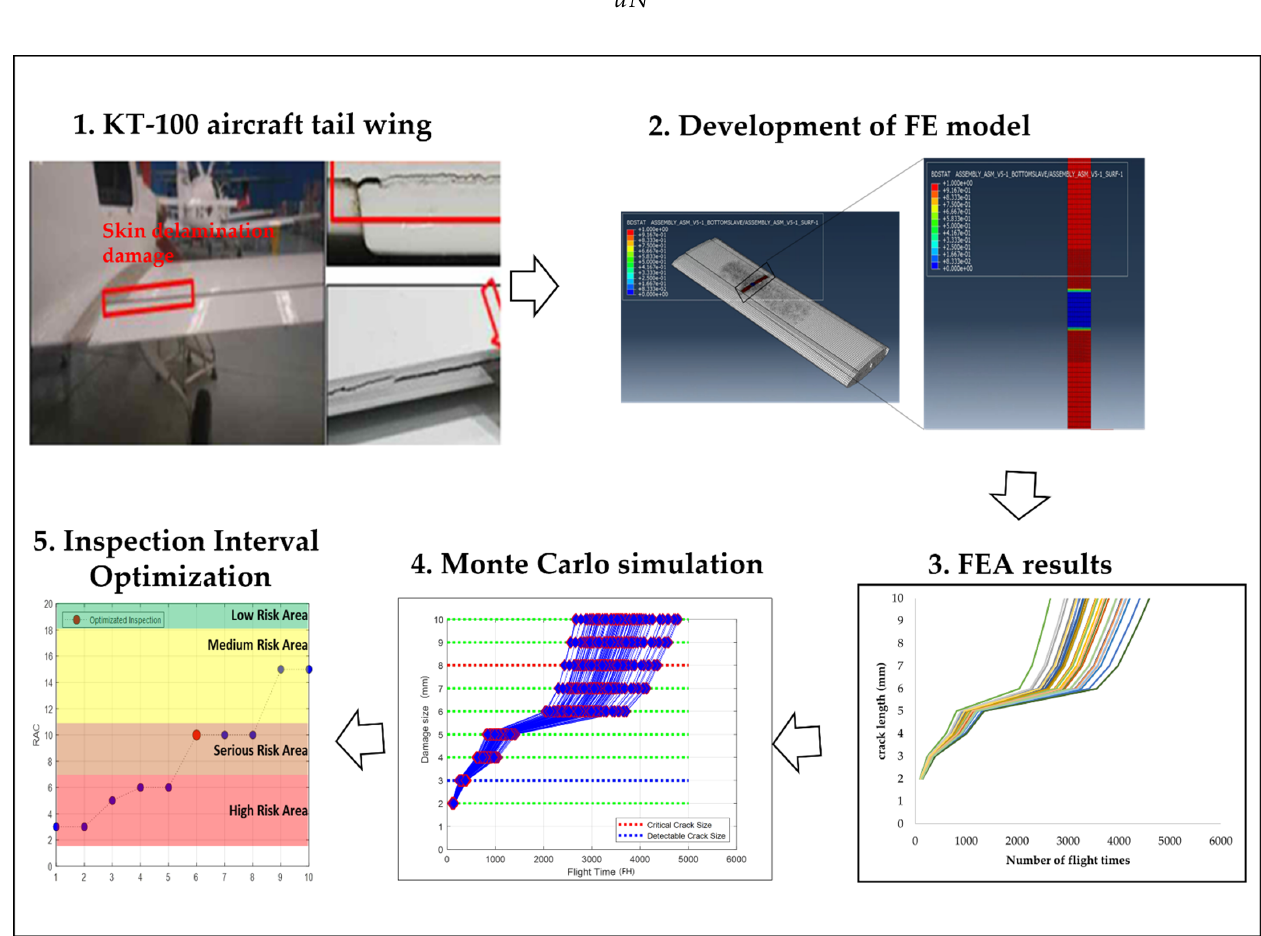
Figure 1. Schematic of the proposed FE-based inspection interval optimization approach.